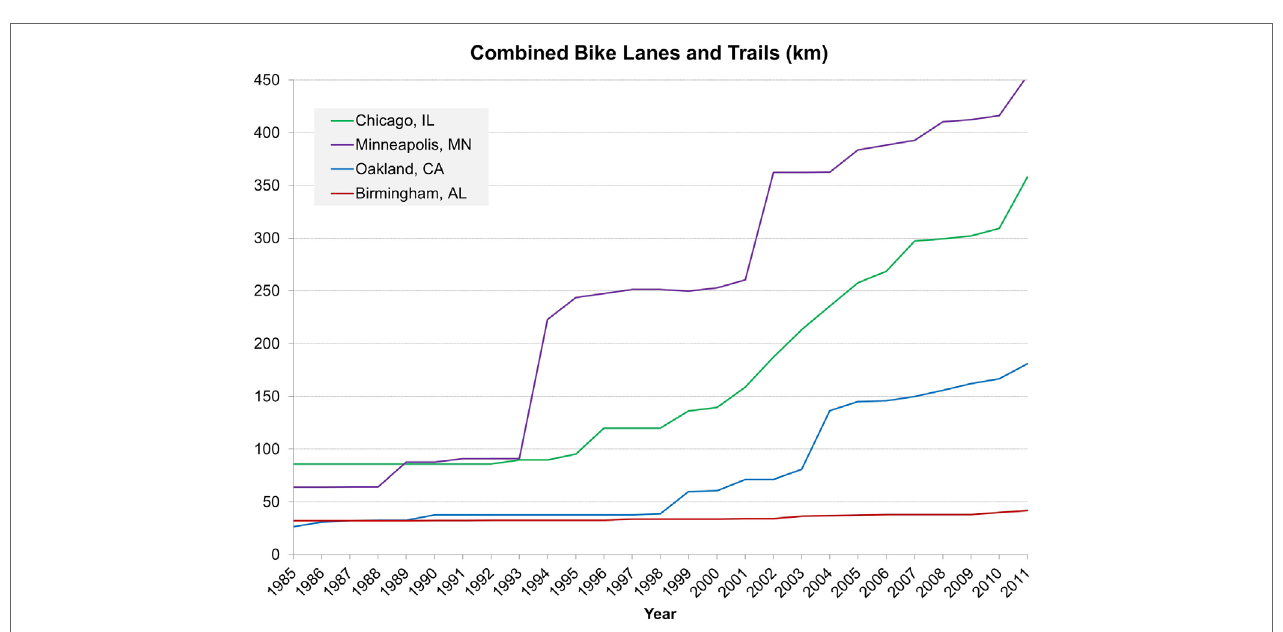
FIGURe 3 | Change in distance of bicycle lanes and recreational trails (kilometers) between 1985 and 2011 by city in the CARdIA four cities field audit . Green represents Chicago, IL, USA; blue represents Oakland, CA, USA; purple represents Minneapolis, MN, USA; red represents Birmingham, AL, USA.